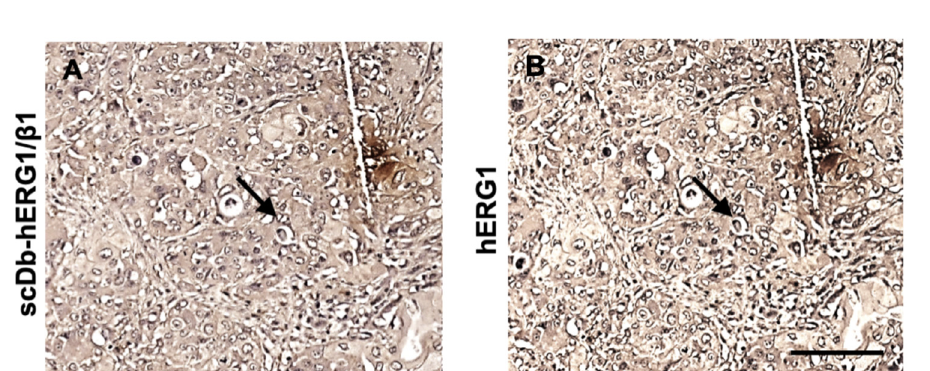
Figure 2. Immunohistochemistry analysis of hERG1 and hERG1- β 1 complex expression in human PDAC samples. Representative images of a PDAC sample expressing the hERG1/ β 1 integrin complex ( A ) and hERG1 ( B ). Arrows indicate the staining of the same cells. Scale bar: 100 µ